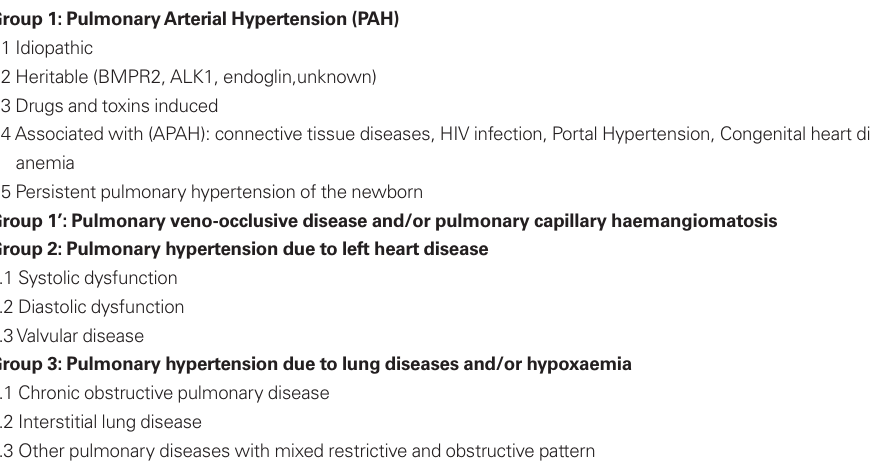
Table 1 | Clinical classification of pulmonary hypertension.